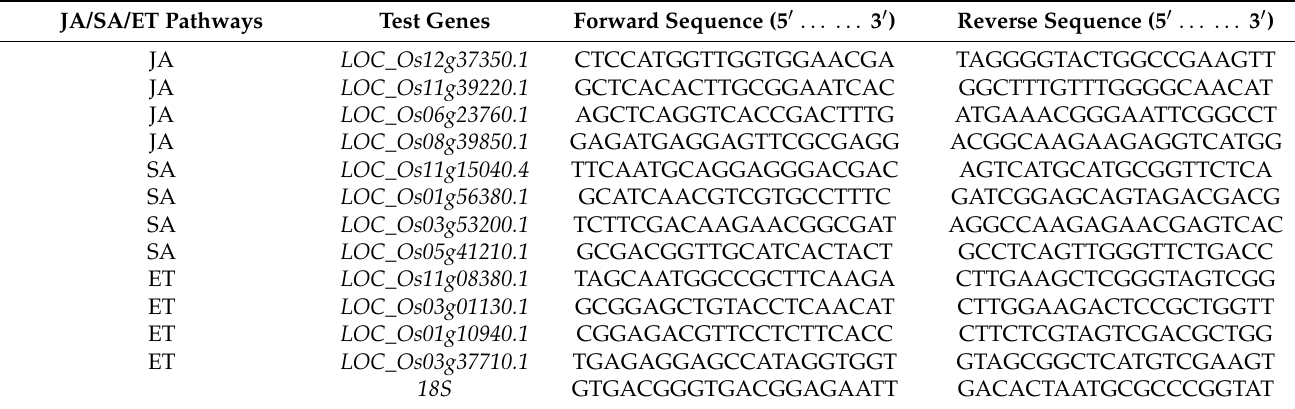
Table 1. Primers for plant defense genes JA, SA, and